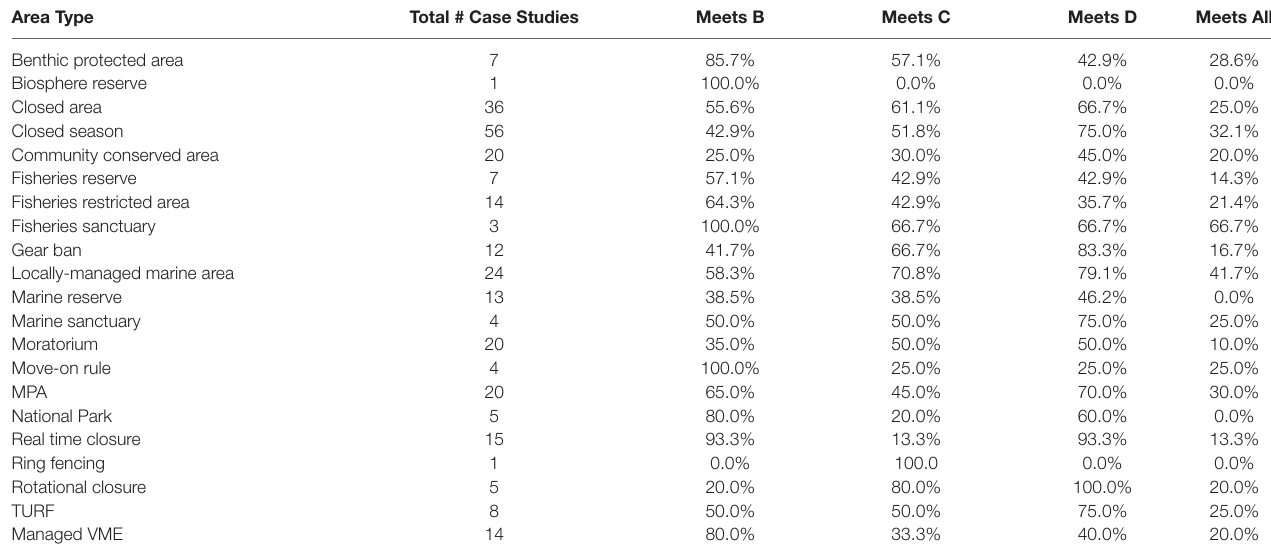
TABLE 4 | Summary of how the subset of case studies that meet Criterion A (i.e., have not been reported to the WDPA) also meet each of the other OECM criteria by ABMT